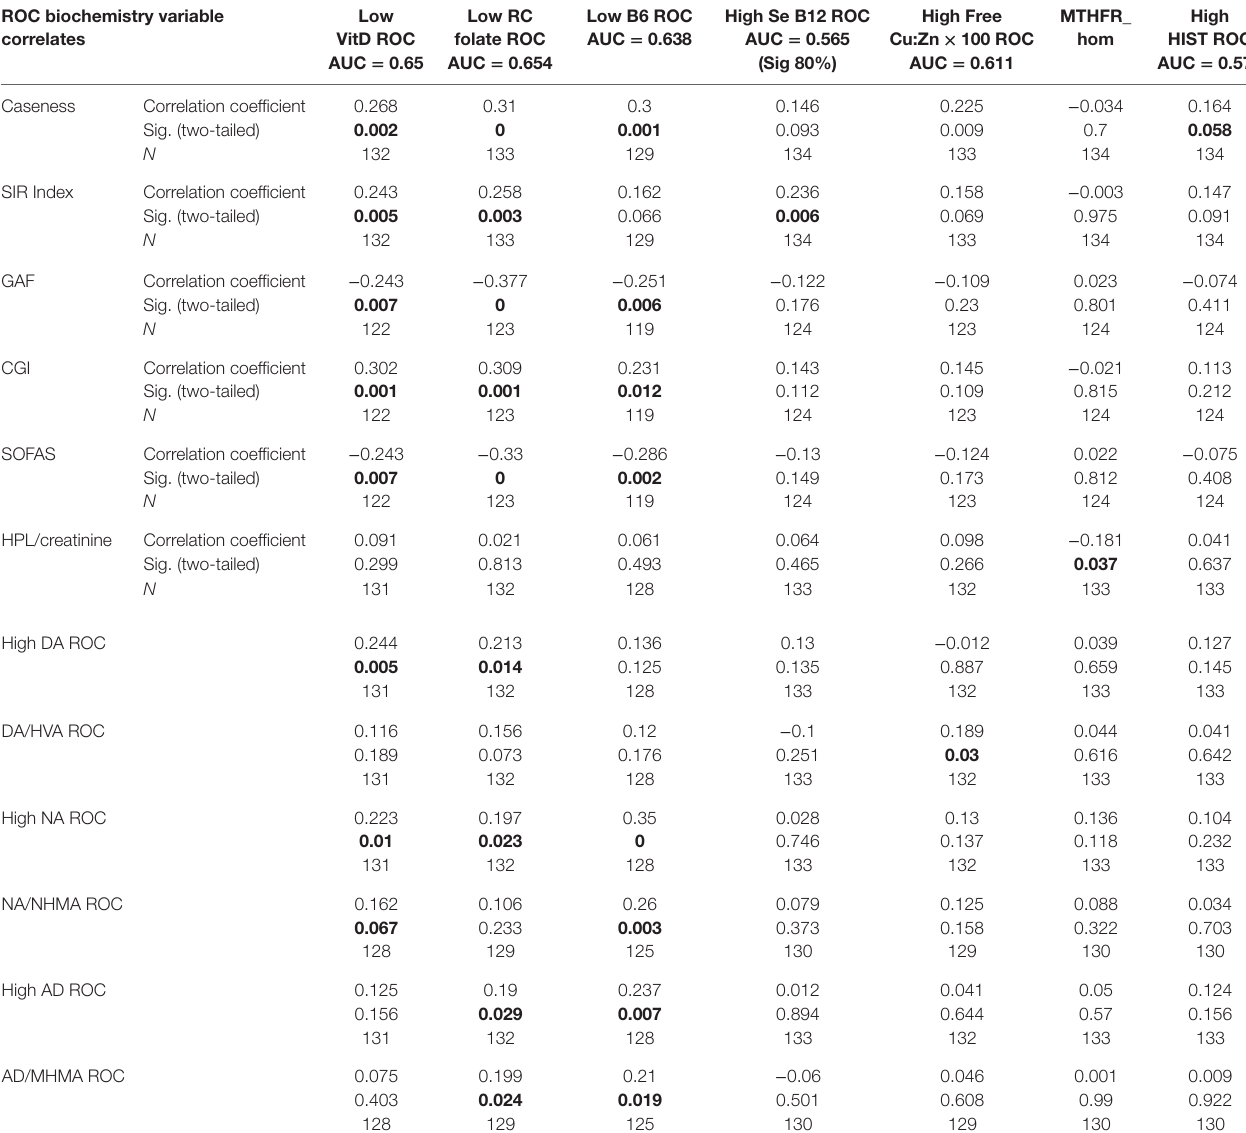
TaBle 3 | Total sample correlation matrix results for rOc biochemistry variables in relationship to each other. rOc biochemistry variable